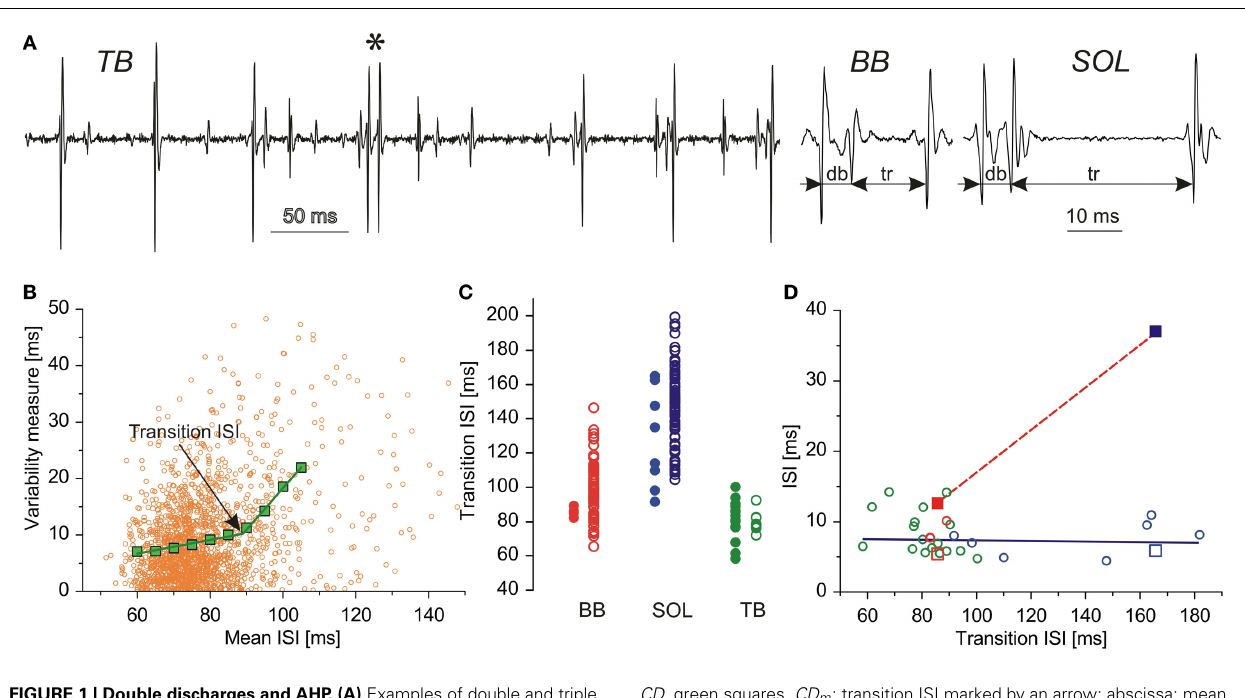
CD , green squares, CD m ; transition ISI marked by an arrow; abscissa: mean ISI; (C) Comparison of transition ISIs for MNs with (heavy circles) and without doublets (open circles); (D) Plots of doublet (open symbols) and triplet ISIs (filled symbols) vs. transition ISI: BB, red; TB, green; SOL, blue. Squares, two MNs capable of firing triplets; circles, remaining